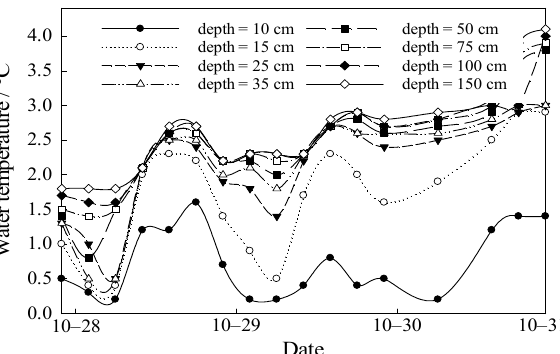
Figure 4. Variations in water temperature beneath the ice during the first 3 days of ice formation.